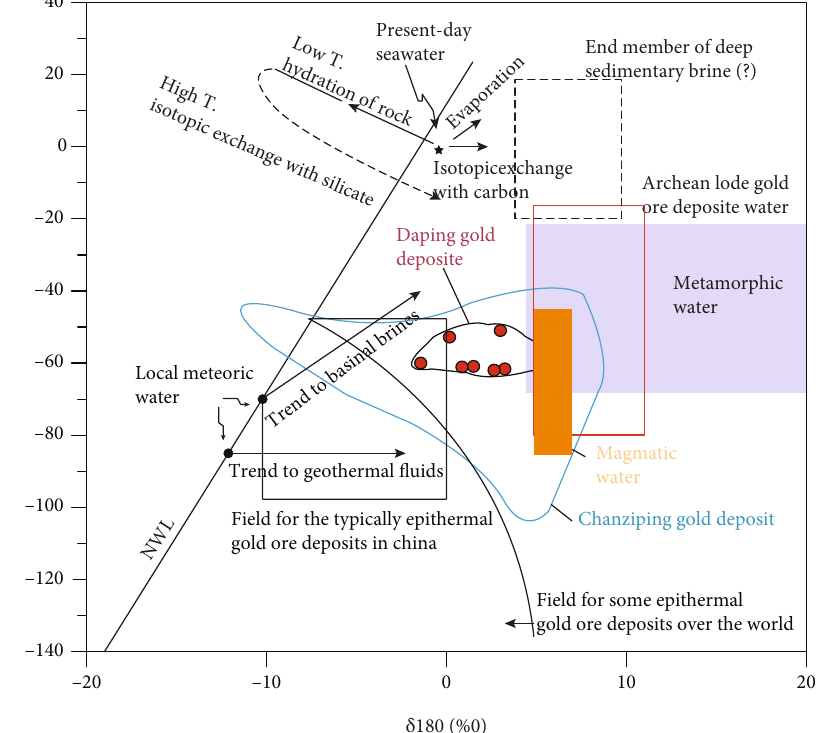
δ 18 O fl uids in Daping gold deposit (modi fi ed after [1]). Primary magmatic and Figure 11: Plot of δ D H 2 O versus H 2 O of the metallogenic metamorphic water boxes and meteoric water line are from [64].